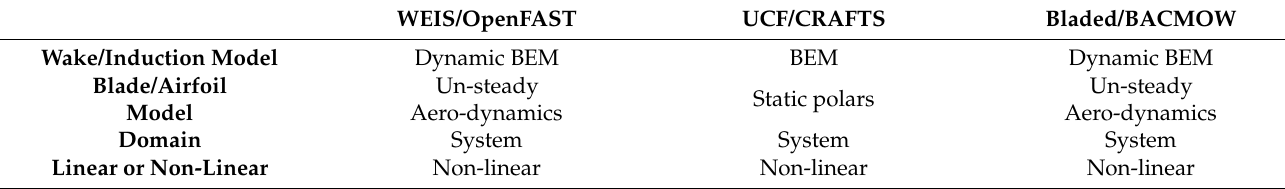
Table 3. Numerical modeling approaches.